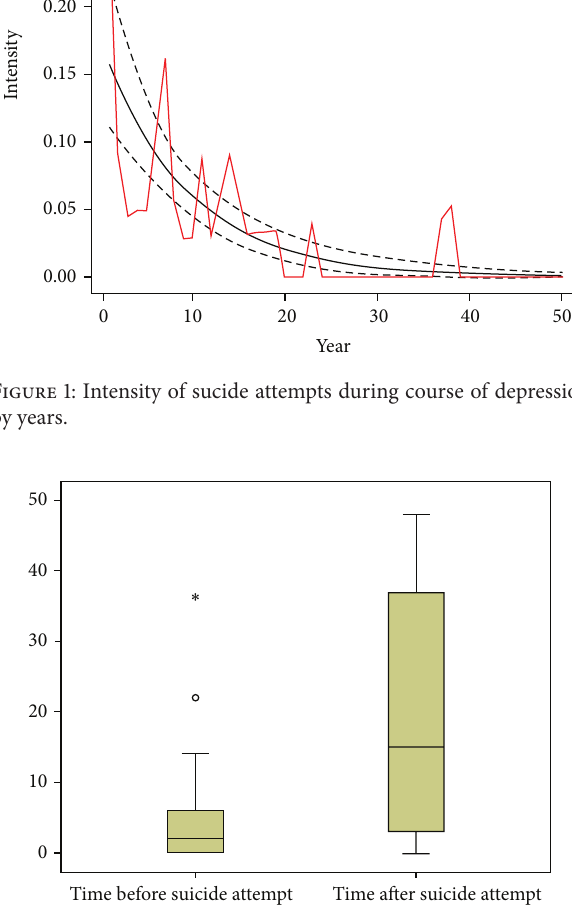
Figure 2: Box plot of years spent in depression before and after first and/or last suicide